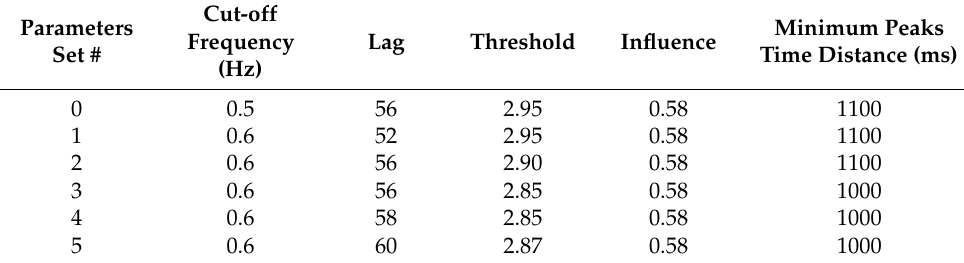
Table 3. Parameter sets used to optimize the chest band’s firmware. Set 0 was the starting set. Parameters